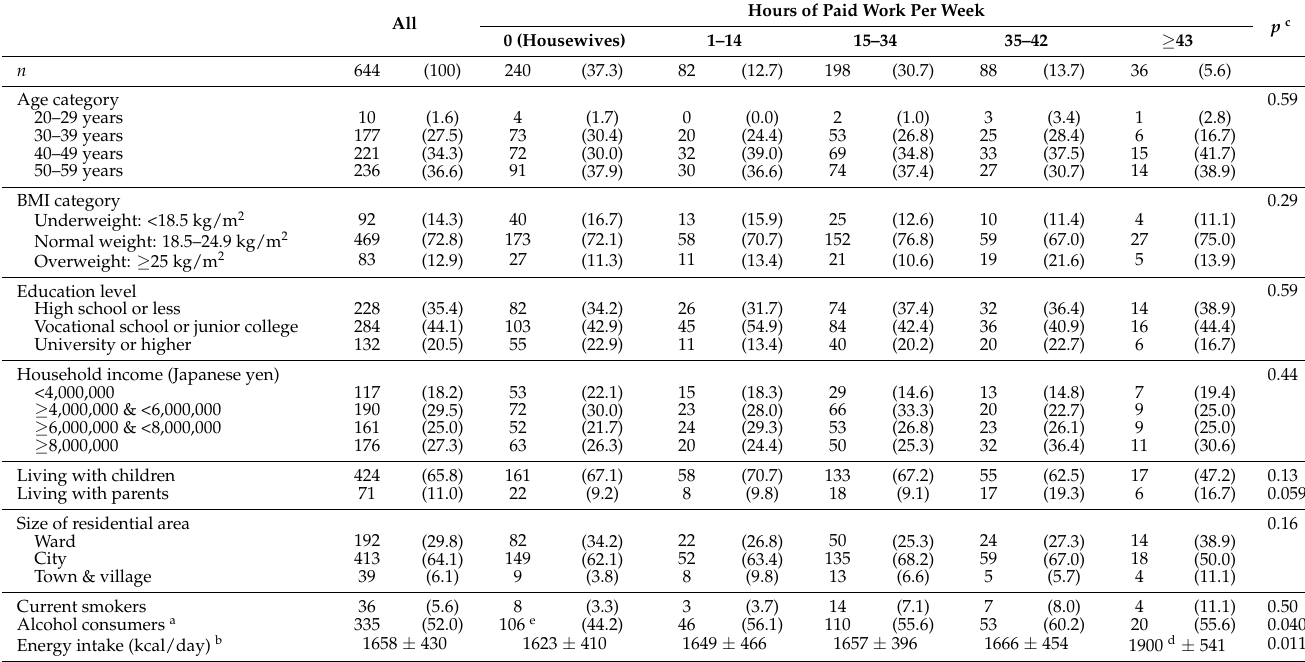
Table 1. Basic characteristics according to the categories of hours of paid work in Japanese married